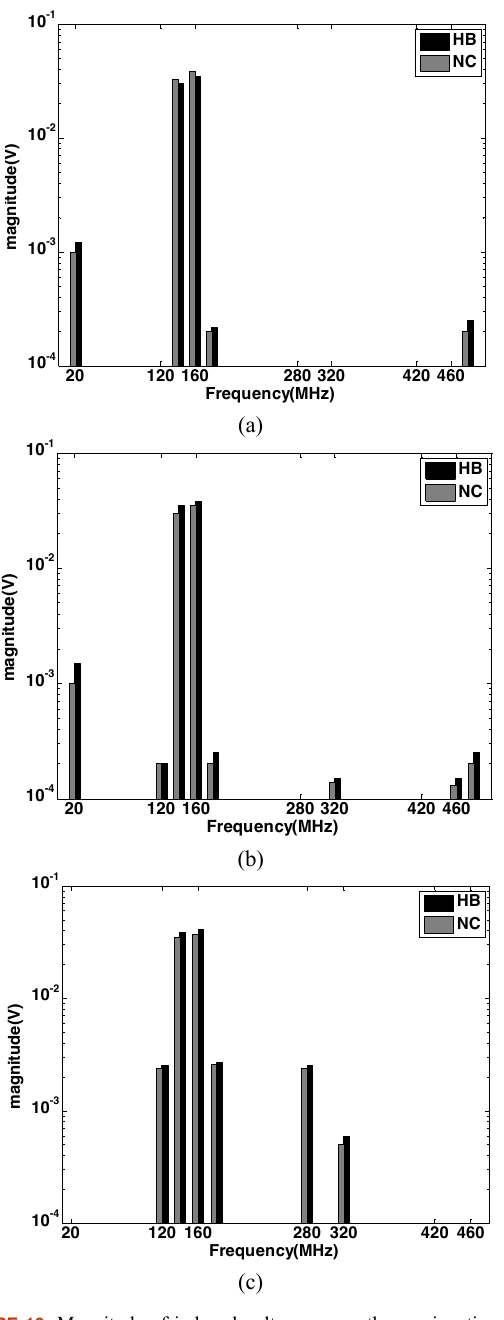
FIGURE 10. Magnitude of induced voltage across the p-n junction diode under double-tone excitation based on the NC and HB techniques in (a): parallel, (b): collinear, and (c): planar